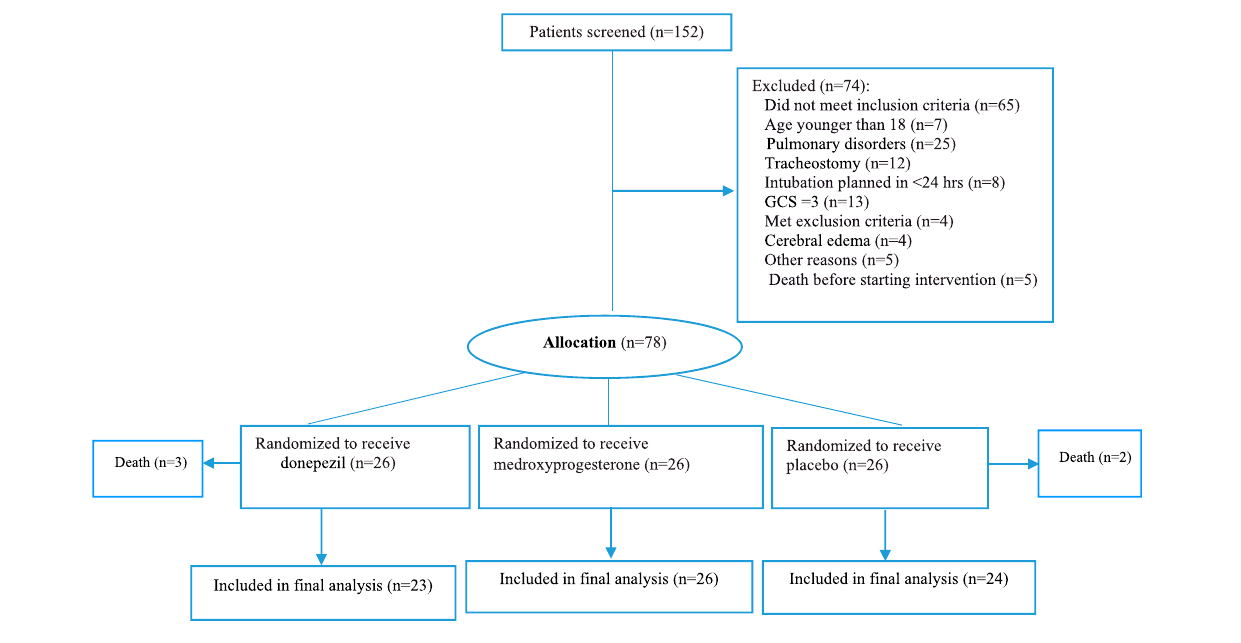
FIGURE 1 | Flowchart of the